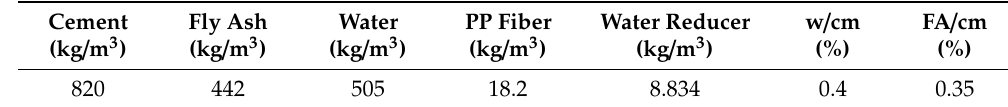
Table 2. Mixture proportion of PP-ECC.